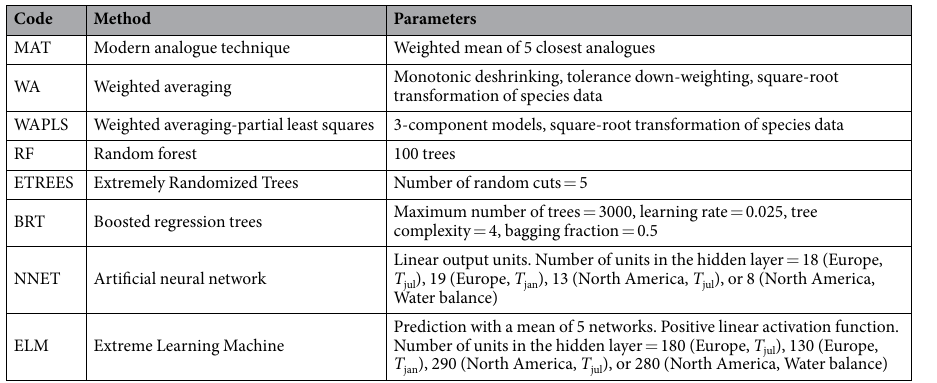
Table 2. Modelling tools used and their